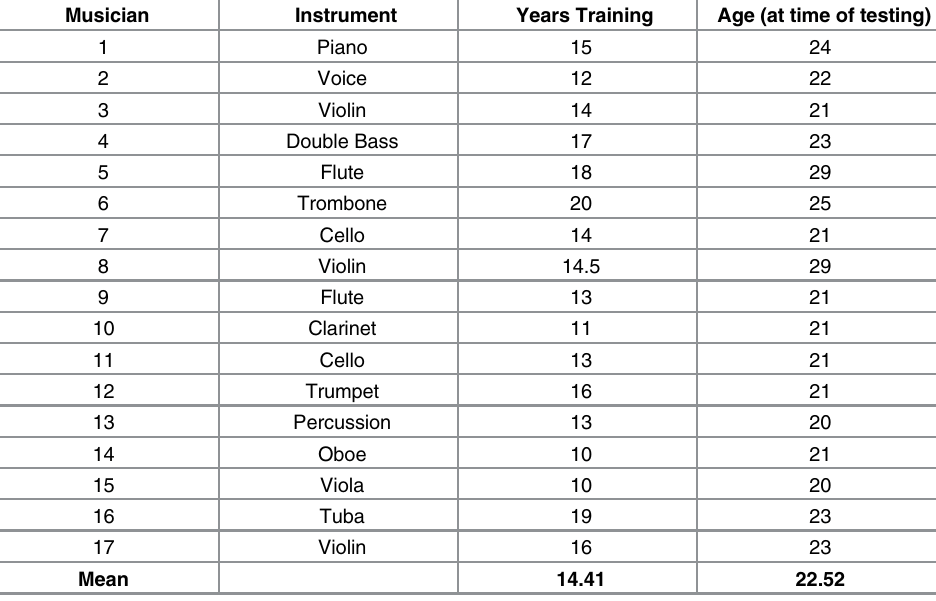
Table 1. Primary instruments, training, and onset of training for the musician